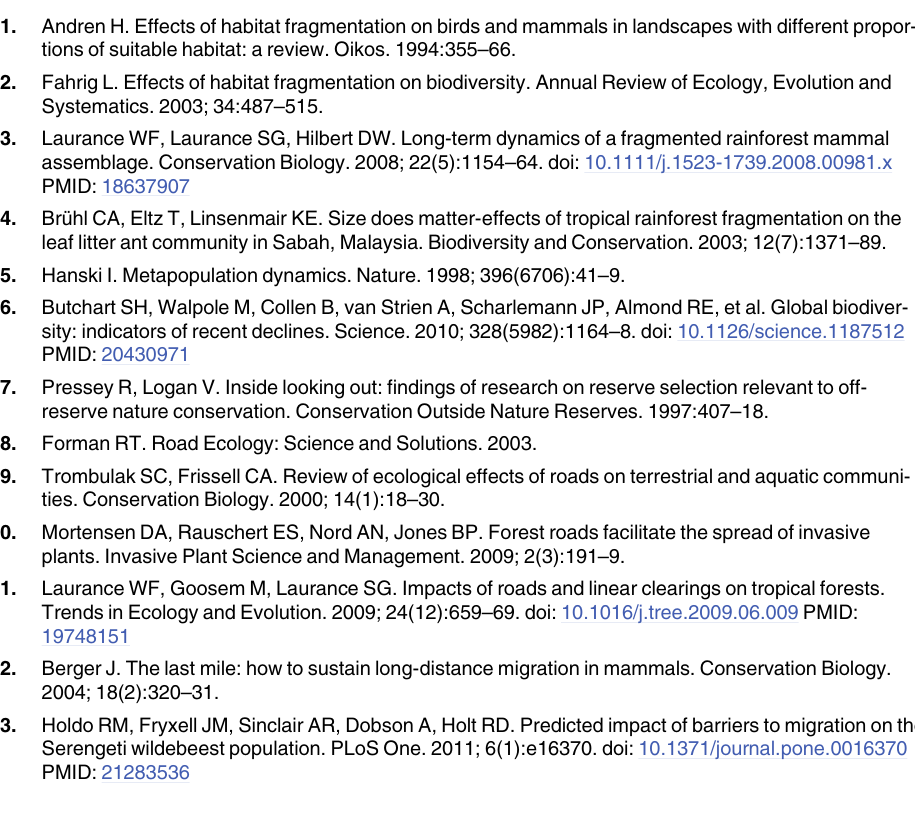
S2 Table. Resource selectionfunctions (RSFs) during winter and summer. S3 Table. Step selectionfunctions (SSFs) during spring and autumn movements. S4 Table. K-fold cross-validationof